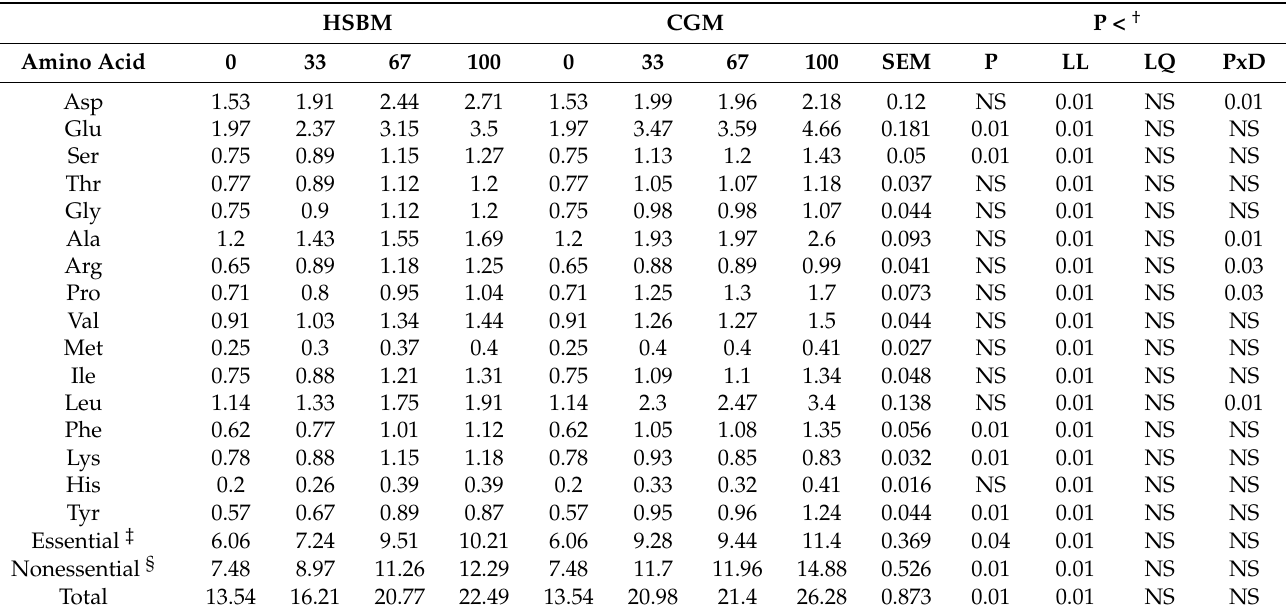
Table 5. Amino acid flow (g/d) from continuous culture fermenters fed diets containing increasing levels of heated soyabean meal (HSBM) or corn gluten meal (CGM).